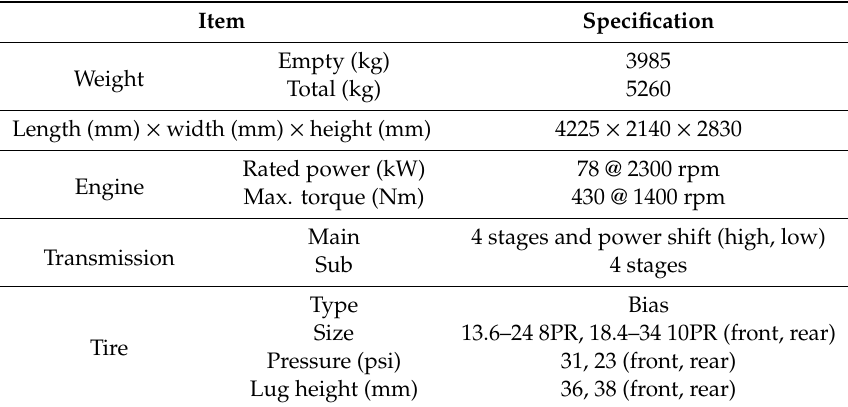
Table 1. Specifications of the agricultural tractor.